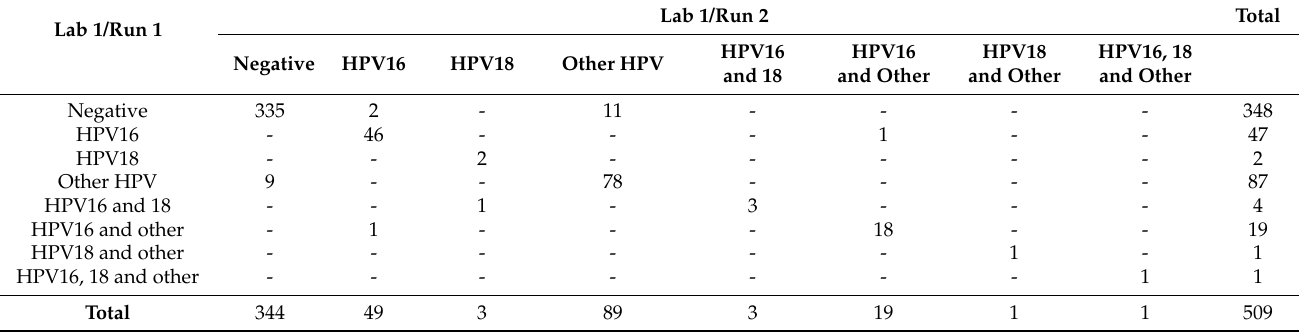
Table 3. Intra-laboratory genotype agreement 1 .